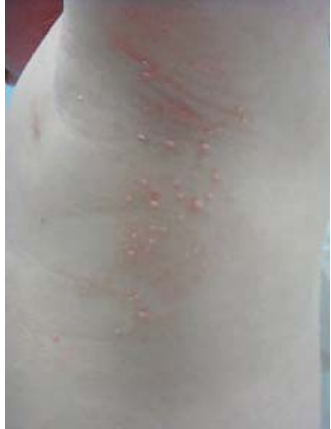
Figure 12. Molluscum